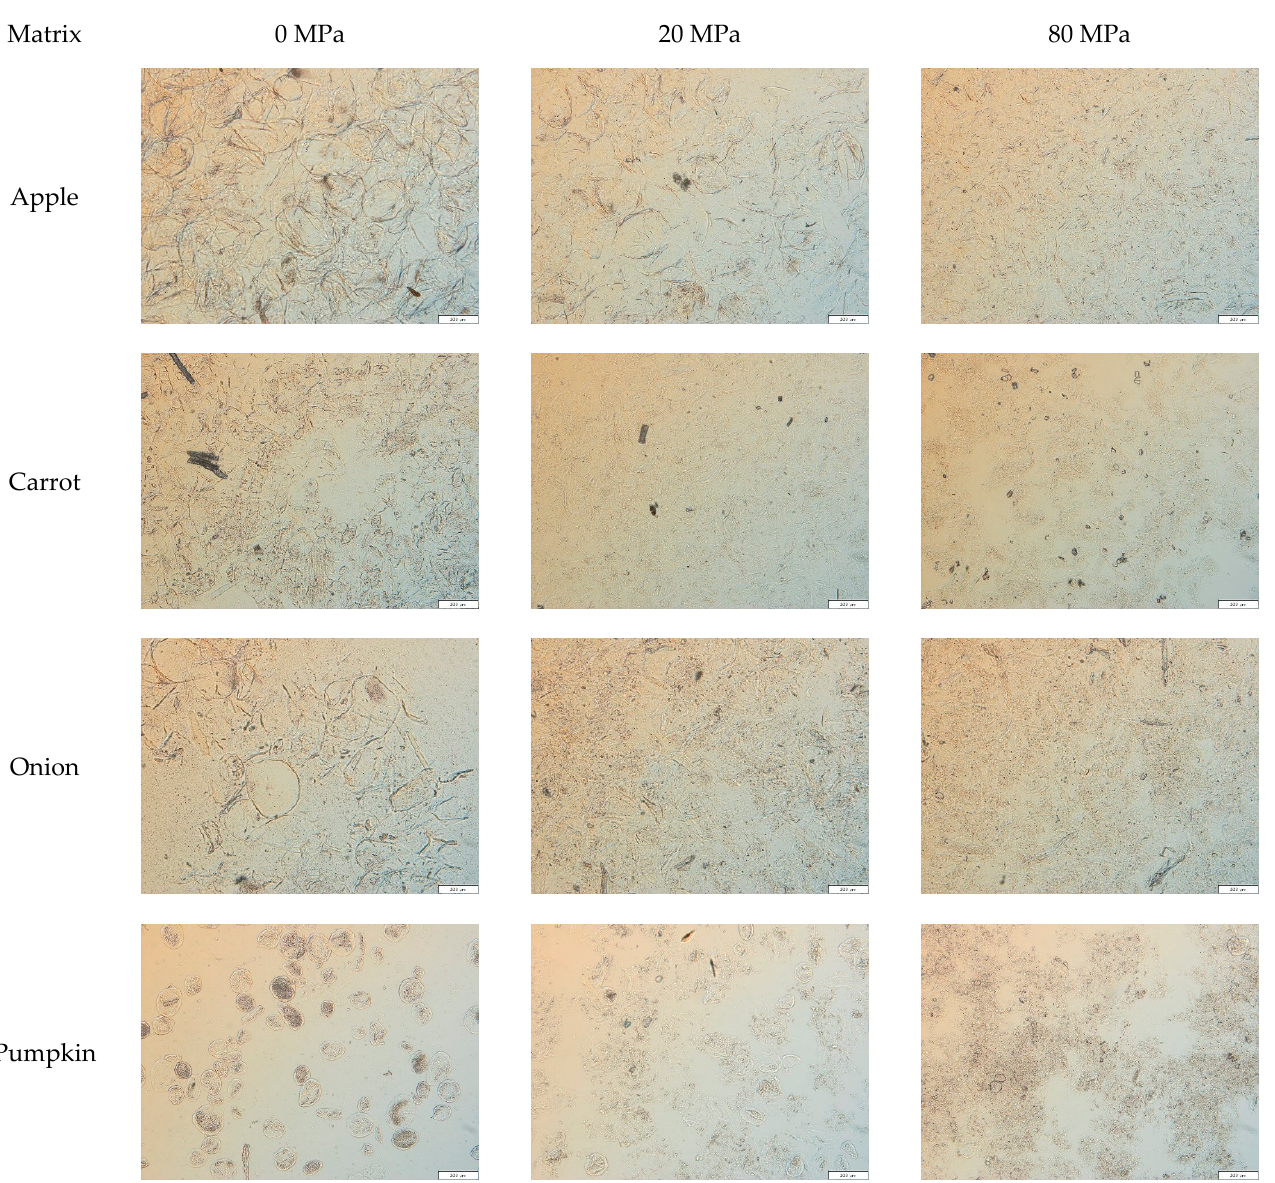
Figure 2. Microscopic visualization of the suspensions prepared with the acid-unextractable fraction of apple, carrot, onion and pumpkin at 0.6% ( w / w ) concentration before (0 MPa) and after high-pressure homogenization at 20 and 80 MPa. The scale bar represents 200 µm.